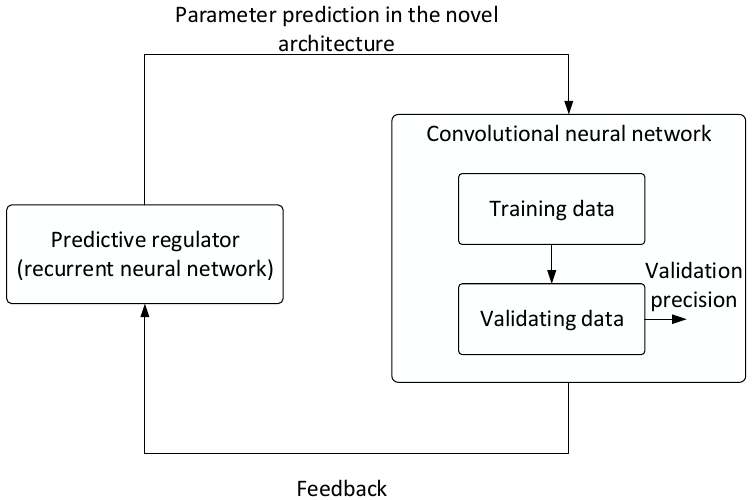
Figure 9. The principle of the machine learning algorithm to assemble a convolutional neural network by utilizing the cloud-based service Google AutoML Vision .